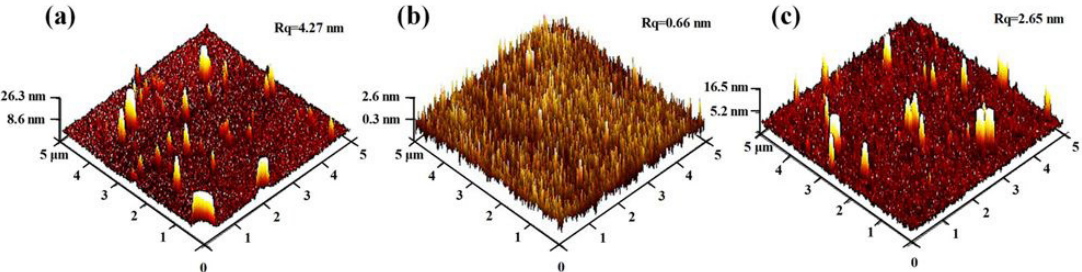
film, (b) an SRSO film, and (c) an Au film deposited on an SRSO film. x